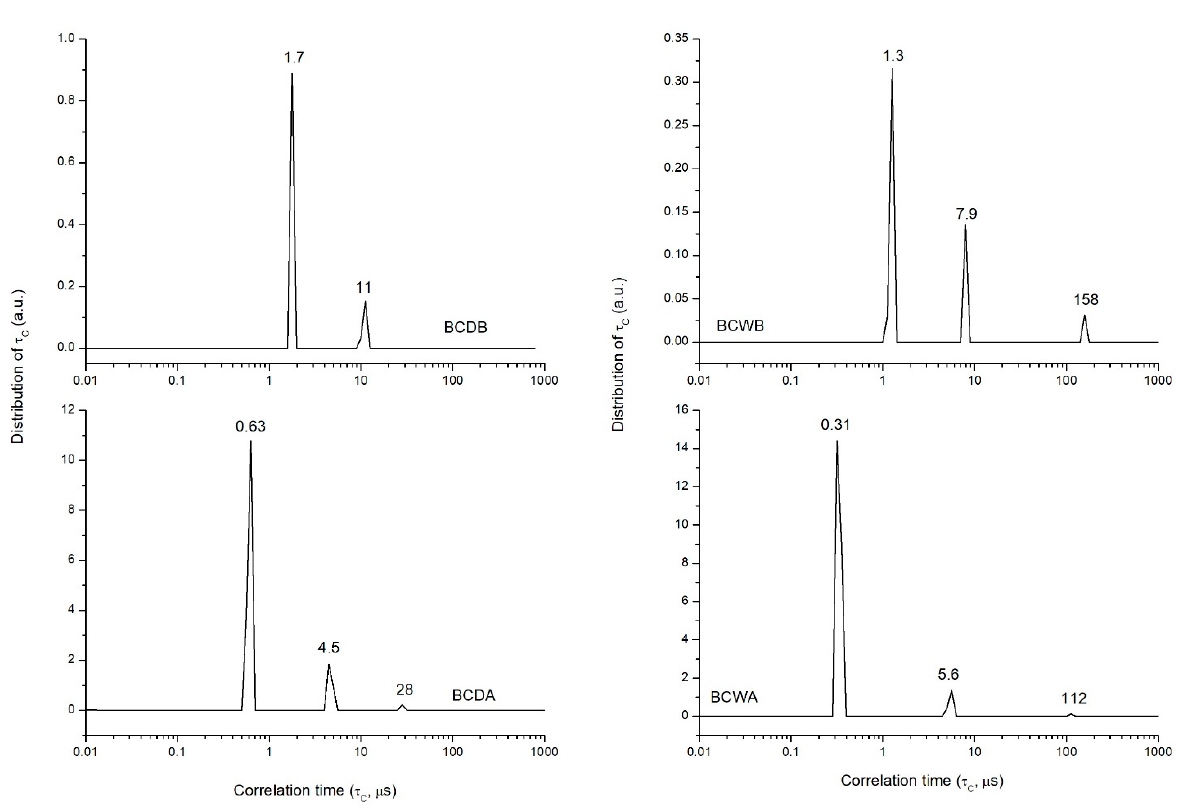
Figure 7. Correlation time distributions for the four biochars studied here.